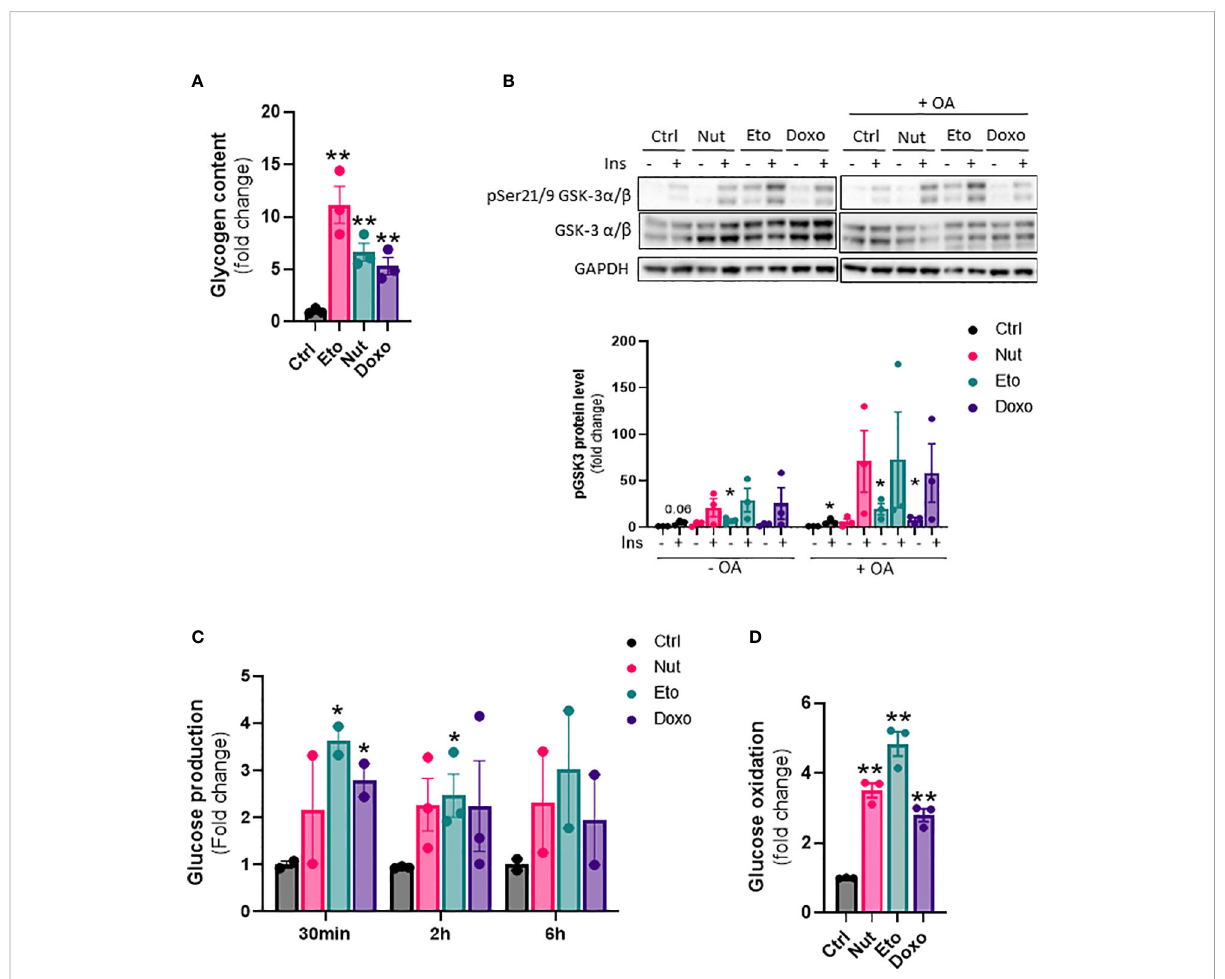
FIGURE 5 Increased glycogen content, glucose oxidation and hepatic glucose production in senescent human hepatocytes. IHH cells were treated with nutlin (Nut; 3 µM), etoposide (Eto; 20 µM) and doxorubicin (Doxo; 0,2 µM) for 5 days. (A) Glycogen content in IHH cells normalized to total protein levels. (B) Western blot analysis and quanti fi cation of pGSK3 (Ser21/9) normalized to total GSK3 levels in IHH cells treated with senescence-inducing drugs for 5 days, with or without the addition of oleic acid for another 24h, and acutely stimulated with insulin (10 nM). (C) Glucose levels in IHH cell culture medium after 30 min, 2h and 6h of incubation. (D) Glucose oxidation in IHH cells normalized to total protein content. Results are expressed as Mean ± SEM. *P < 0.05, **P < 0.01 indicates a signi fi cant difference compared to control